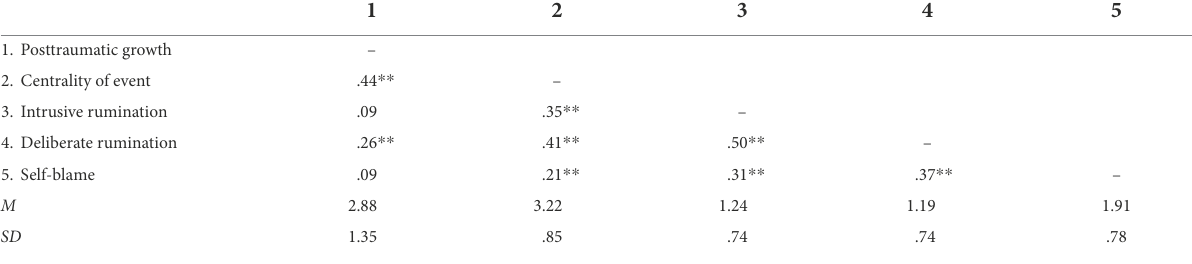
TABLE 2 Correlations among study variables, and descriptive